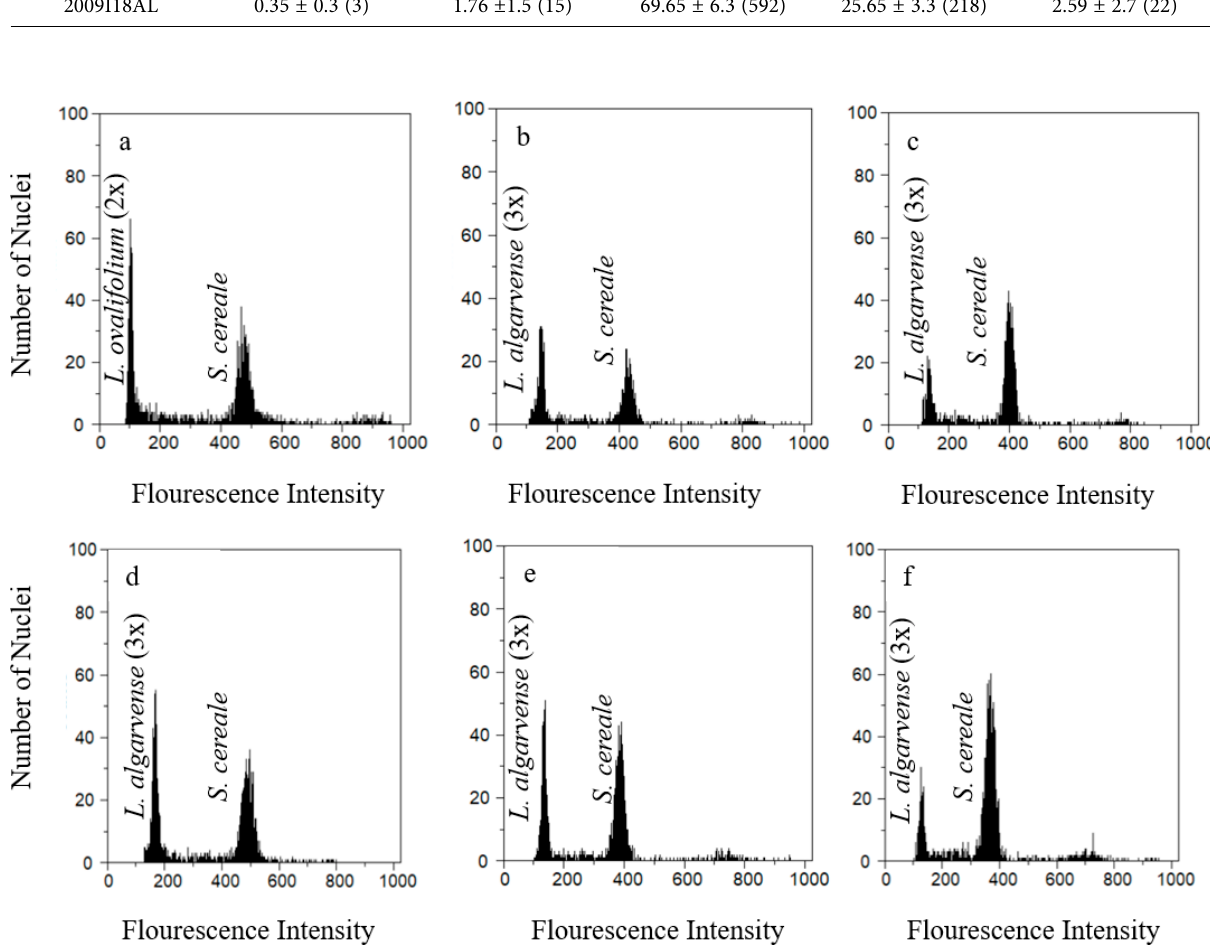
Figure 6. Flow cytometric histograms of seeds of L. ovalifolium (a) and L. algarvense ( b-f